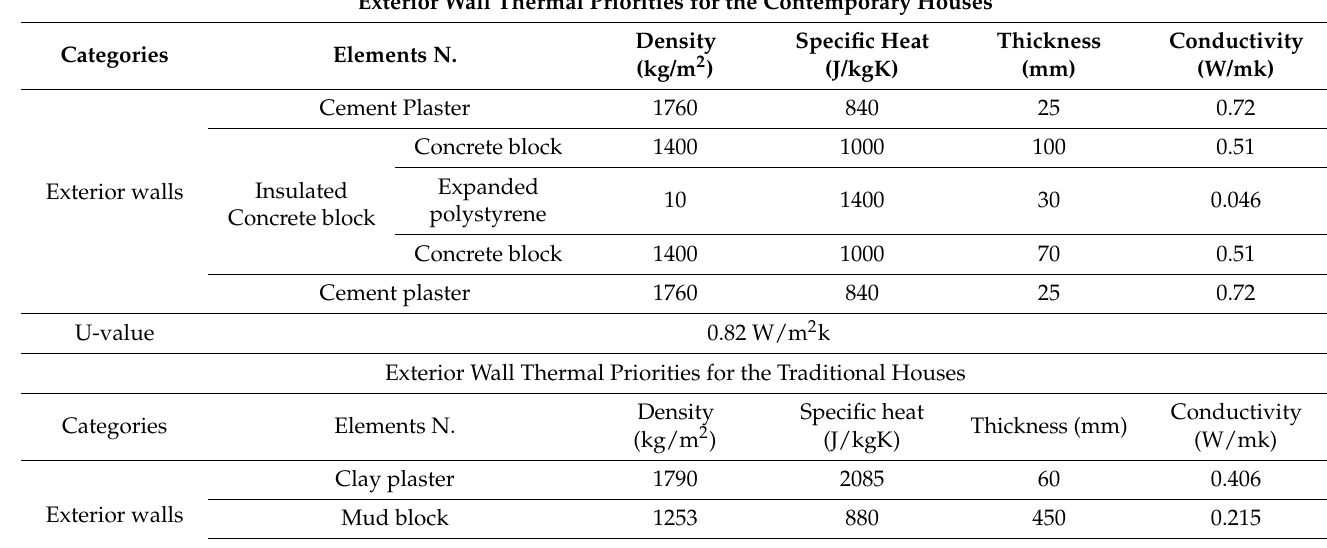
Table 1. Exterior wall structure and thermal propriety for traditional and contemporary houses.